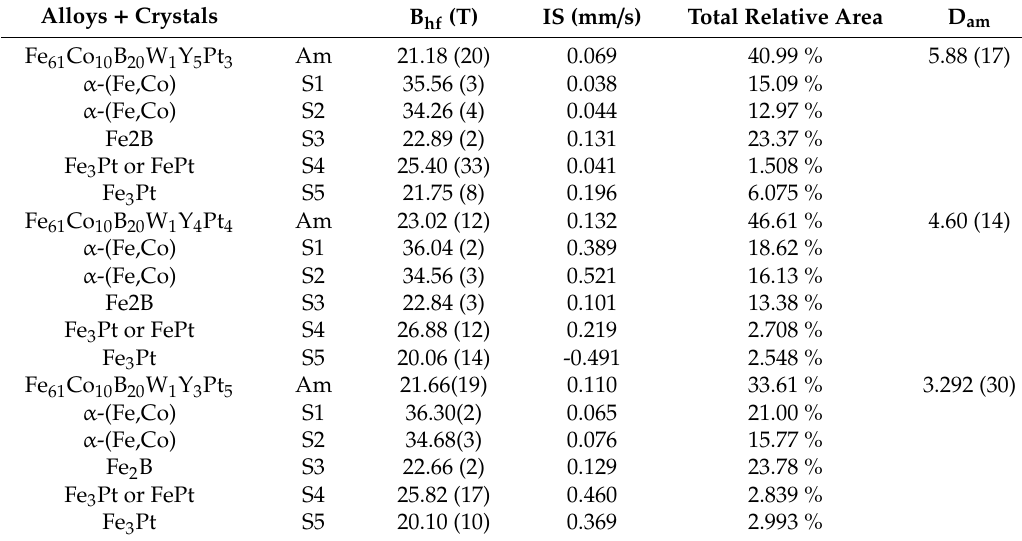
Table 1. The value of the mean hyperfine field using the 57 Fe nuclei (B hf ), dispersion of the hyperfine field distributions of the amorphous phase (D am ), and isomer shift